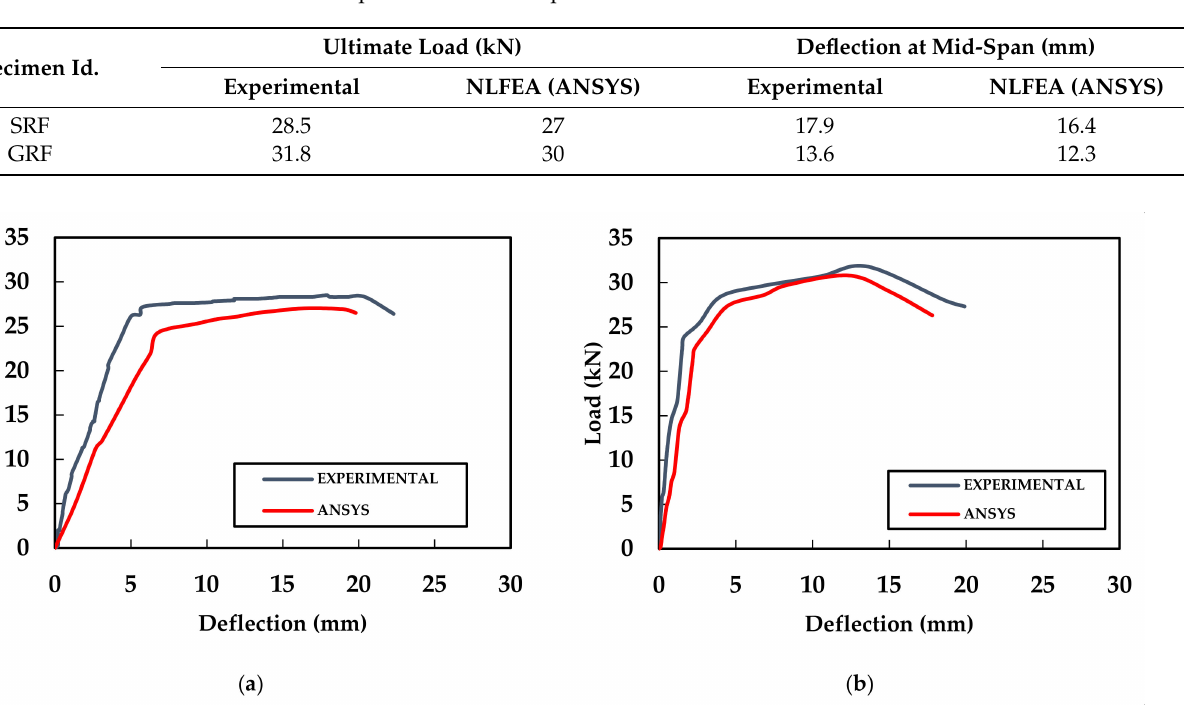
Table 8. Comparison between experimental and numerical results.